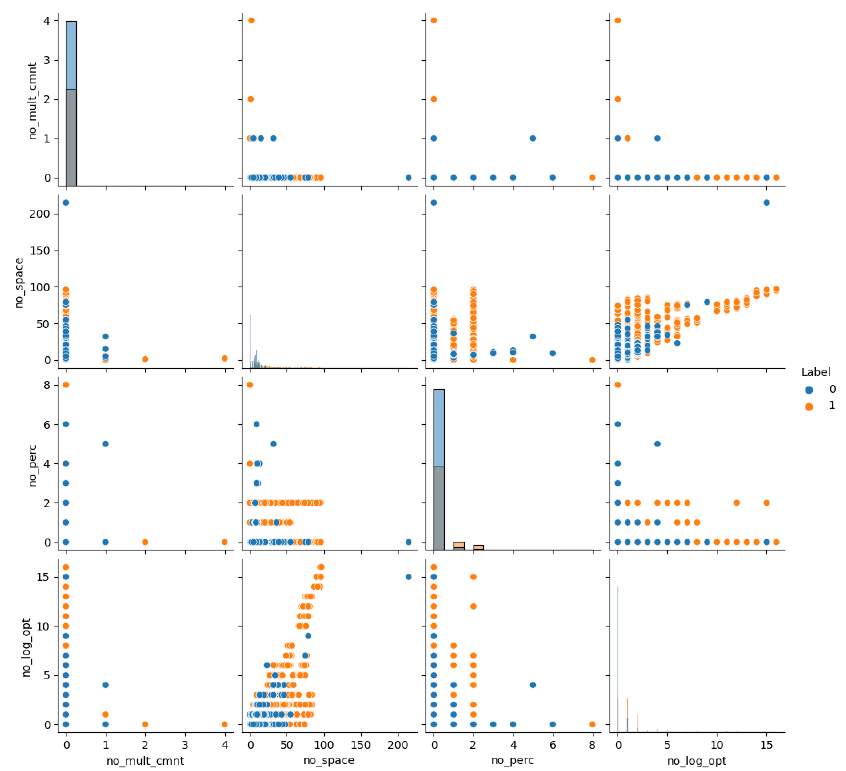
Figure 14. Paired plots of sampled features. The correlation between the two variables was determined by selecting features (here, features 7 to 10) by random sampling and performing bivariate analysis.